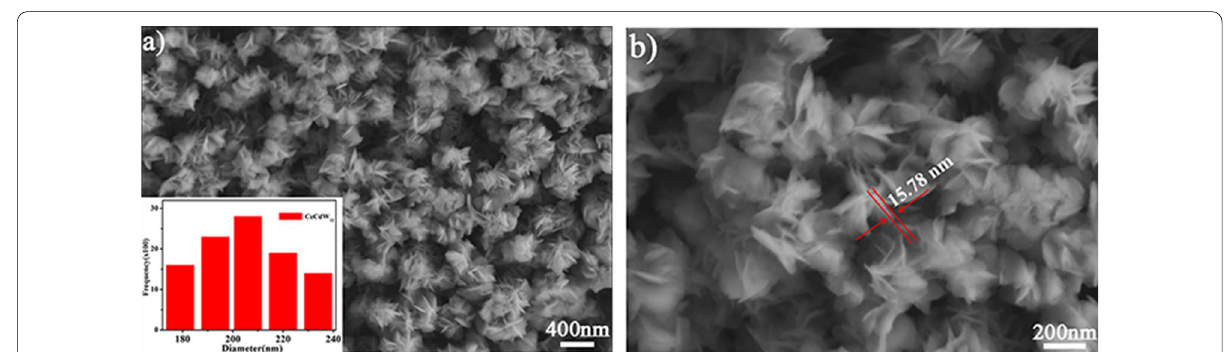
Fig. 6 SEM images of CeCdW 12 nanoflowers (inset: size distribution)